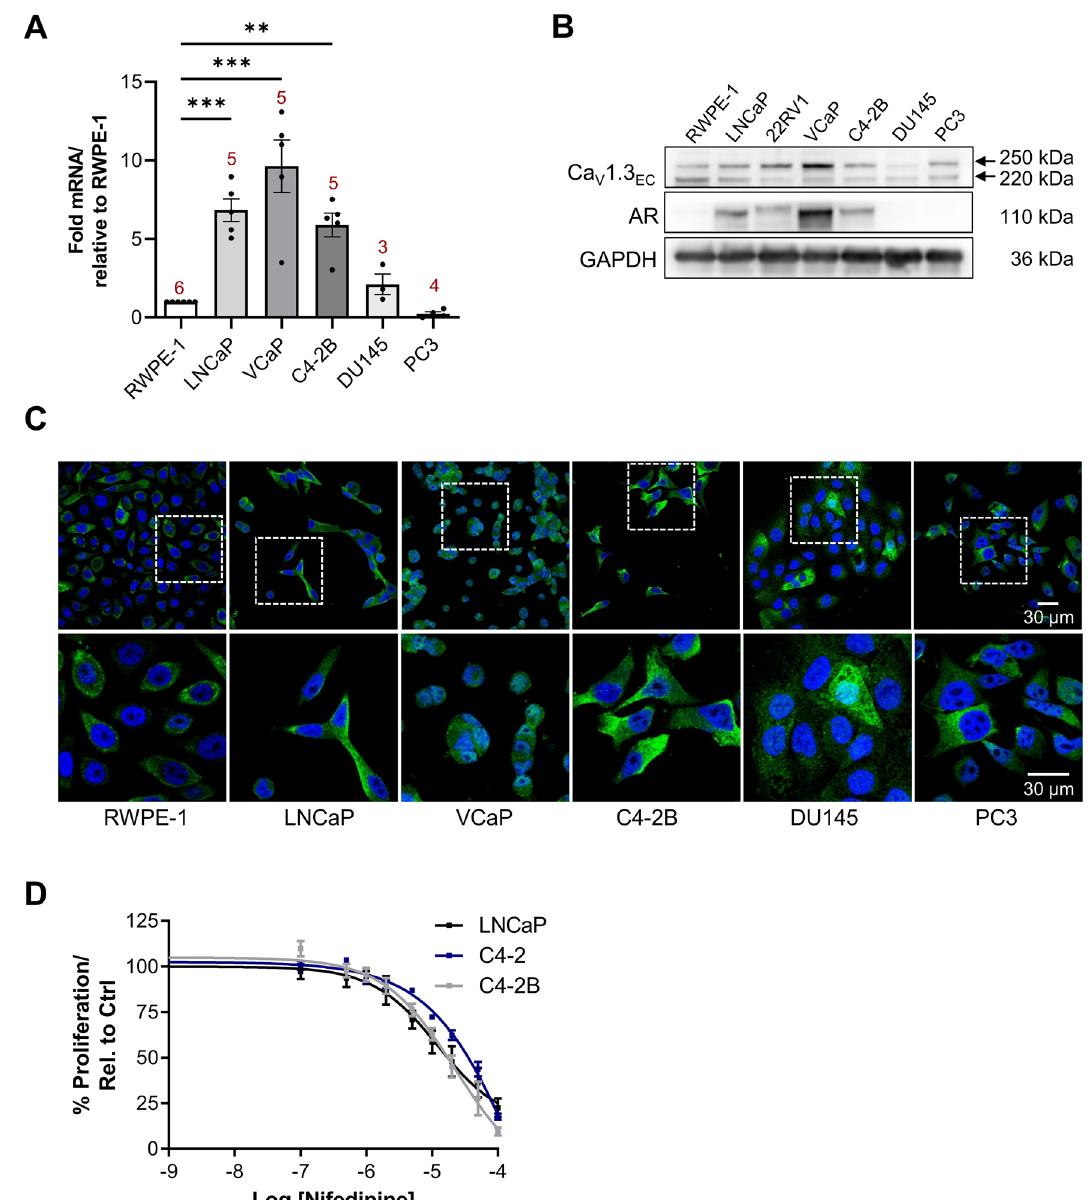
Figure 2. Ca V 1.3 expression profiling using in vitro PCa cell lines. ( A ) qPCR was performed to assess CACNA1D transcript expression in normal and PCa cell lines. RPLPO was used as an endogenous reference control. Fold changes were determined by normalisation to RPLPO and RWPE-1 transcript levels. Data was analysed using 1-way ANOVA (Dunnett’s) where p < 0.01 (**), p < 0.001 (***) comparing PCa cells to RWPE-1 (N indicated above each bar). ( B ) Protein expression of Ca V 1.3 and androgen receptor, AR was analysed in the panel of cell lines in Western blots with GAPDH as a loading control (N = 3). Uncropped original blots are displayed in Supplementary Fig. S4. ( C ) Immunofluorescence micrographs of Ca V 1.3 (green) and nuclear staining by DAPI (blue) for each cell line (N = 3). White boxes in the top row of micrographs are shown at higher magnification in the bottom row. ( D ) Summary data (mean, SEM) of proliferation across LNCaP, C4-2 and C4-2B treated with nifedipine (0–100 µM) for 72 h (N = 3) showing concentration-dependent decrease in